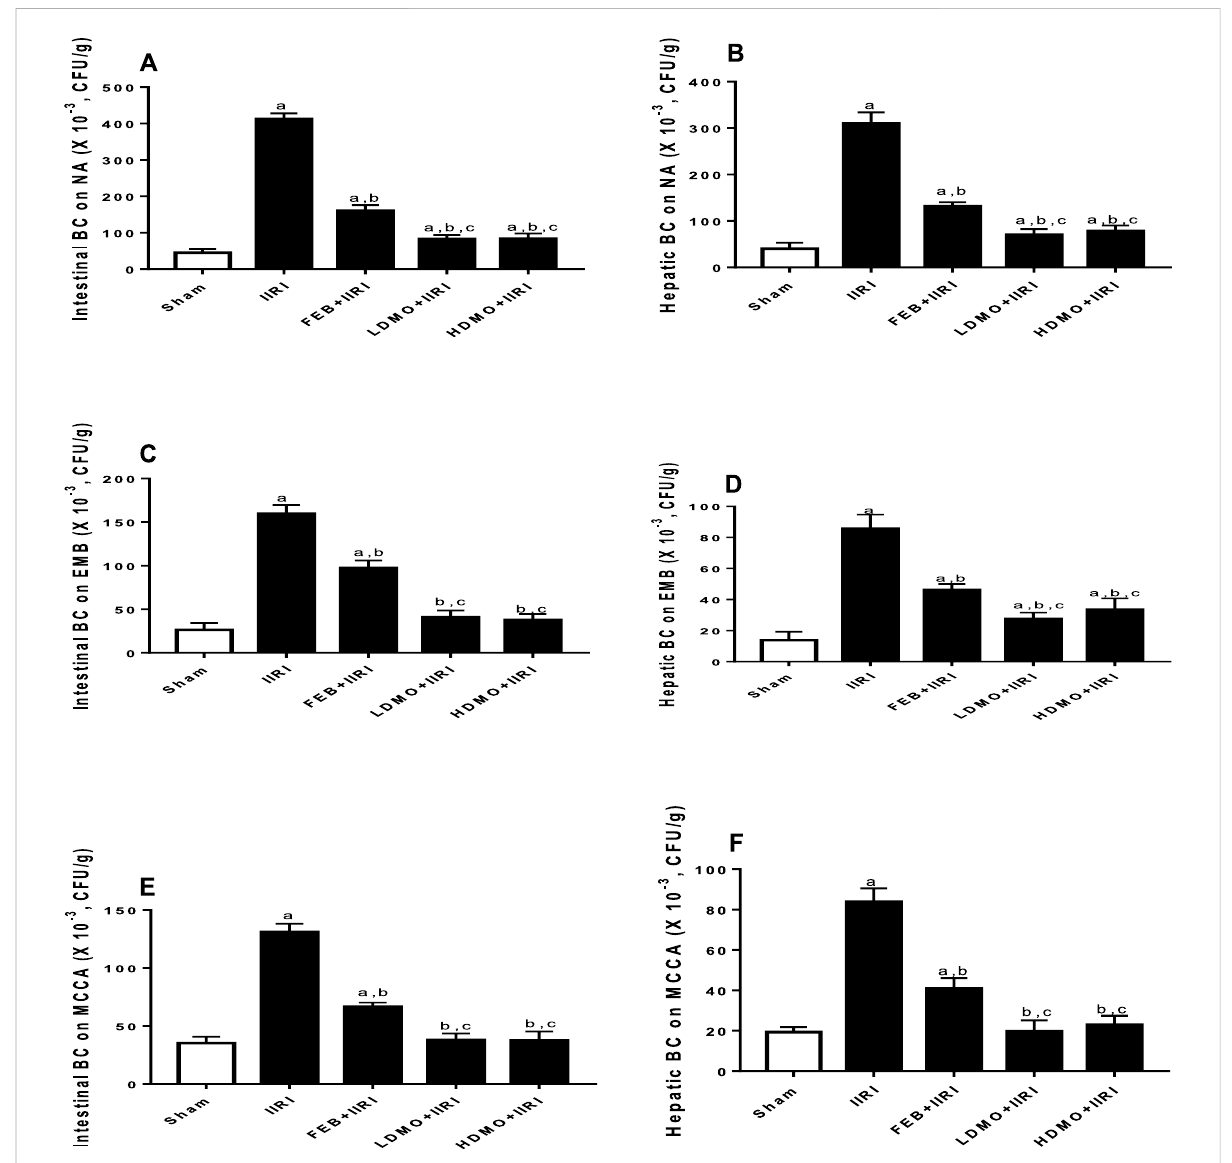
FIGURE 9 Effect of intestinal ischaemia/reperfusion (I/R) and methanolic Moringa oleifera leaf extract on intestinal and hepatic bacterial count (BC) using nutrient agar (NA), eosin-methylene blue (EMB), and Mac Conkey agar (MCCA) culture media for colony count. IIRI: Intestinal ischaemia/reperfusion injury, FEB: febuxostat, LDMO: low dose Moringa oleifera, HDMO: high dose Moringa oleifera, a p < 0.05 versus sham, b p < 0.05 versus IIRI, c p < 0.05 versusFEB +IIRI.Data wereanalyzed byone-wayANOVA followed byTukey ’ sposthoc test. Values are expressed as mean ± SD of10 rats per